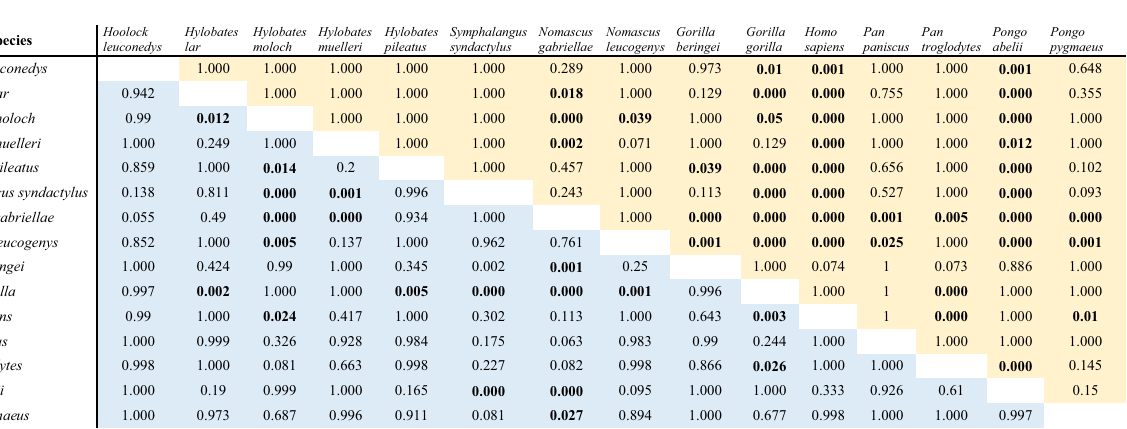
Table 3. Species-level comparison of highest ocular contrast (HC) and relative iris luminance (RIL) between hominoids. Values of the upper triangular matrix (orange) correspond to statistical results for HC, those of the lower one (blue) to RIL. Bold values indicate significant results (HC: Bonferroni-corrected Wilcoxon tests; RIL: Tukey’s Honest Significant Differences).